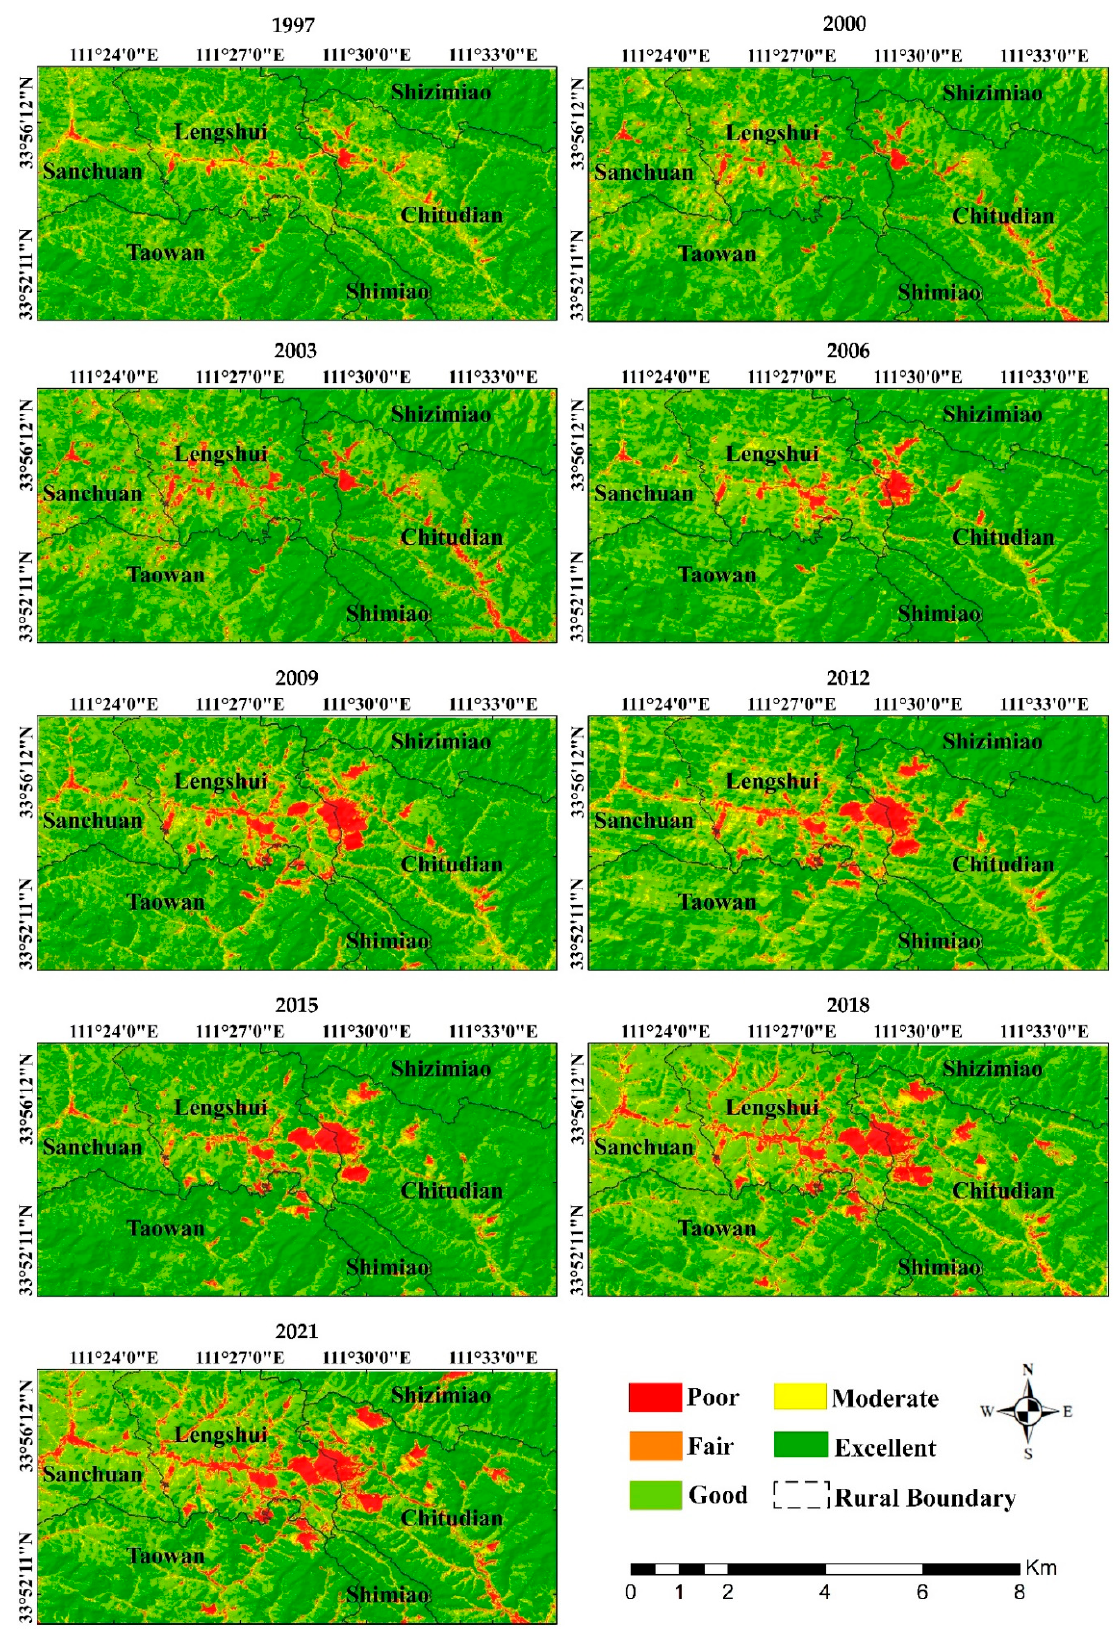
Figure 6. Ecological statuses of mining areas in 1997, 2000, 2003, 2006, 2009, 2012, 2015, 2018, and 2021.